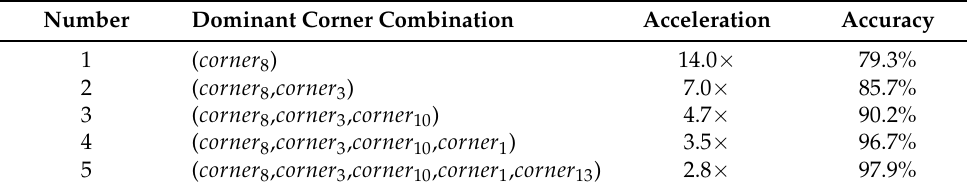
Table 2. An example of PAF